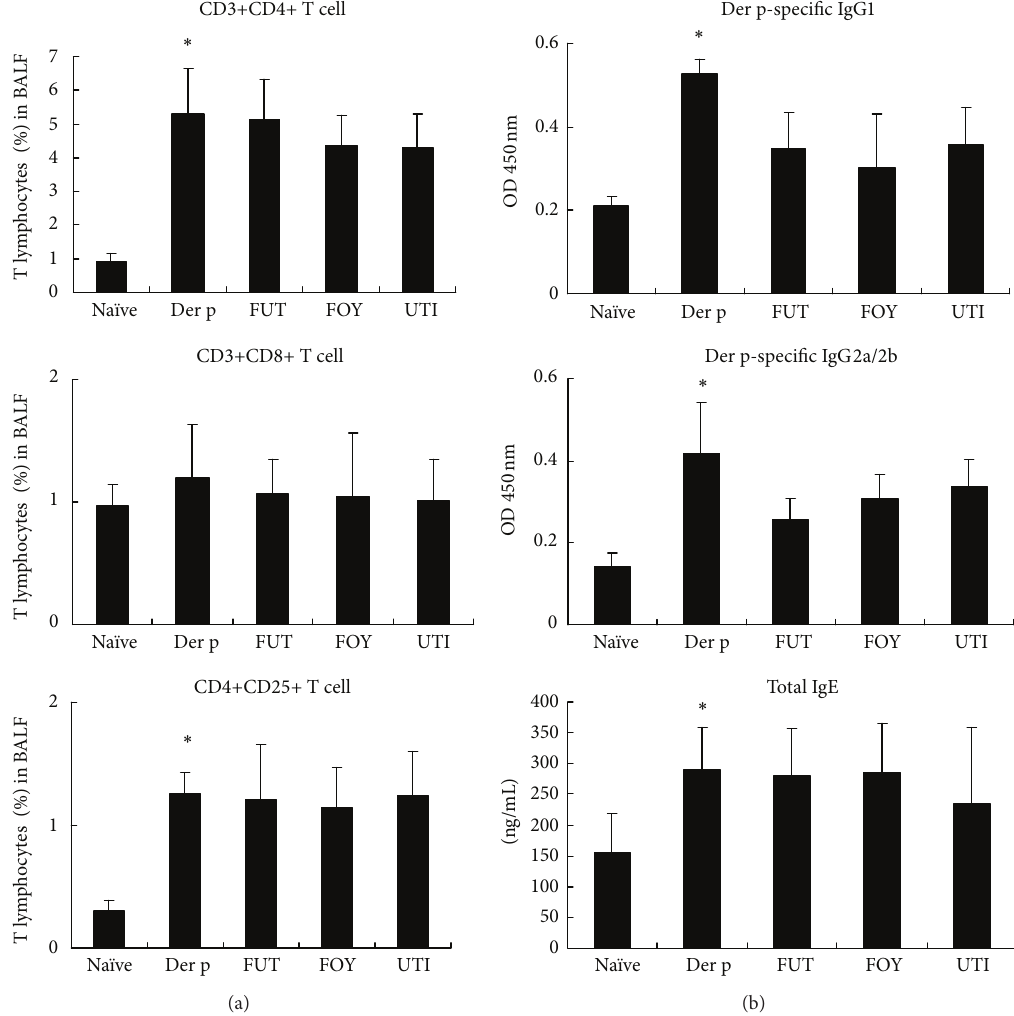
Figure4:EffectsofproteaseinhibitorsonT-cellsubsetsinBALFandserumantibodies.(a)ThepercentageofCD3+/CD4+,CD3+/CD8+,and CD4+/CD25+ lymphocytes was determined by flow cytometry. (b) Total IgE and Der p-specific IgG1 and IgG2a/2b levels were determined by ELISA. Results are expressed as means ± SD’s for 6 mice/group. ∗ 𝑃 < 0.05 versus na¨ıve group; # 𝑃 < 0.05 between Der p-treated